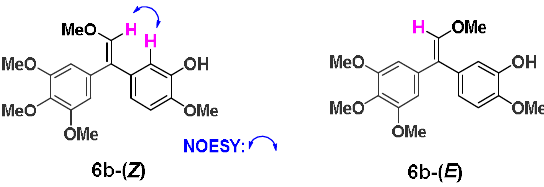
Figure 2. 6b-( Z ) and 6b-( E ) after HPLC preparation. Selected NOE correlations of 6b-( Z ) .